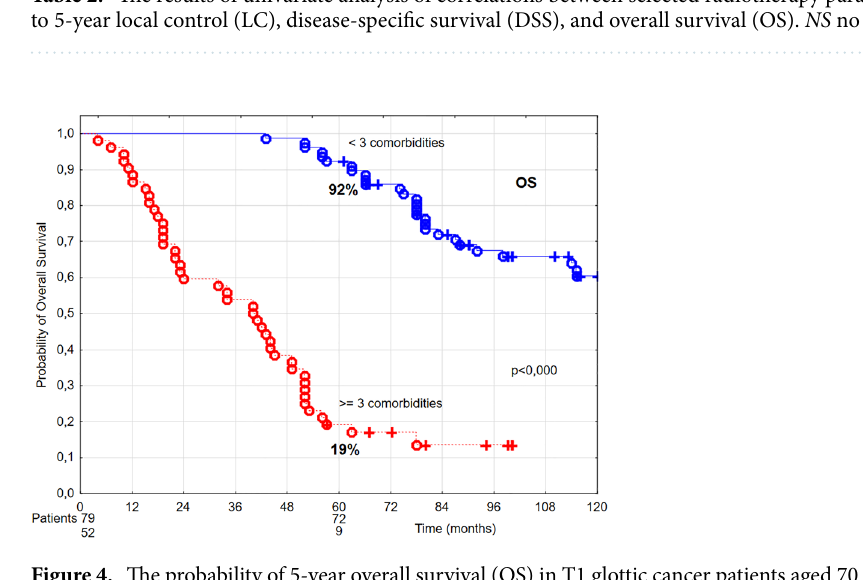
Figure 4. The probability of 5-year overall survival (OS) in T1 glottic cancer patients aged 70 and above in relation to the number of